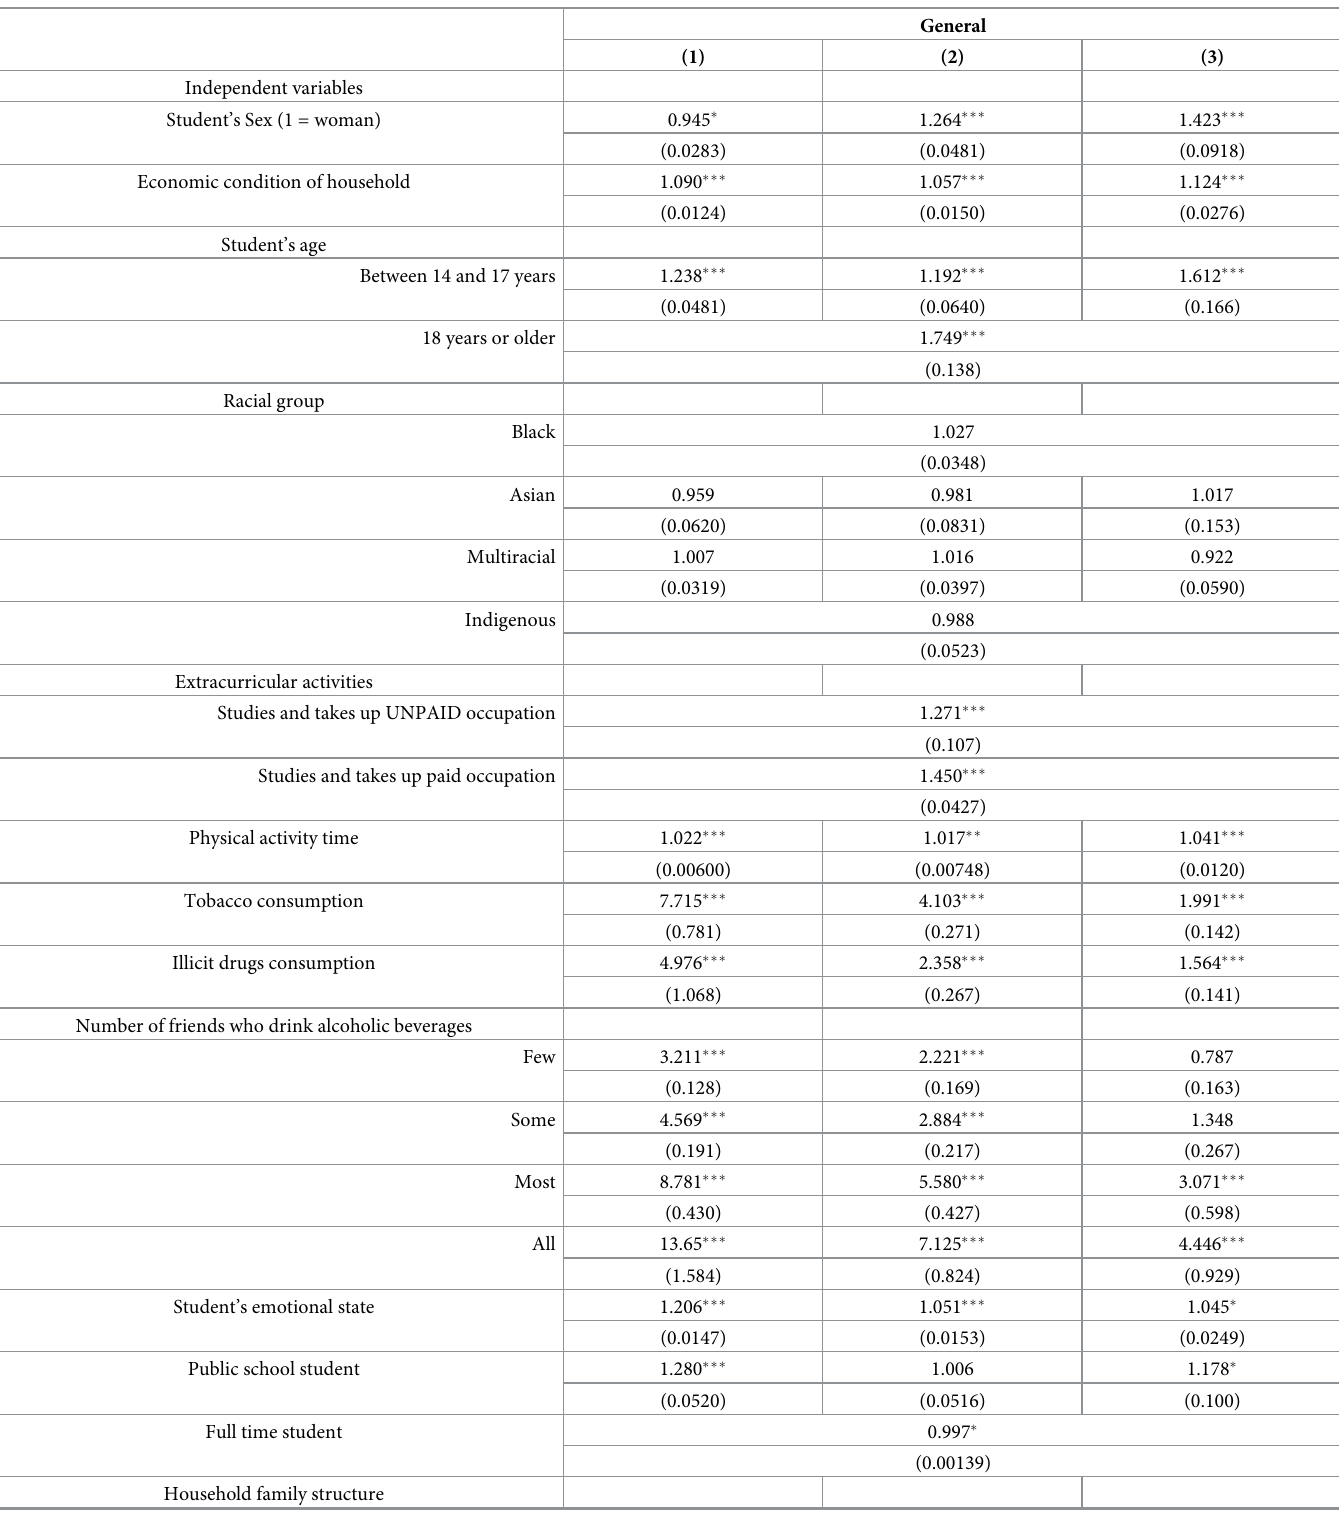
Table 2. Results of the sequential logit model (in odds